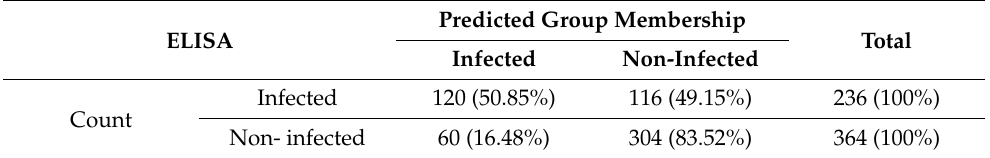
Table 7. Results of animal classification into infected and